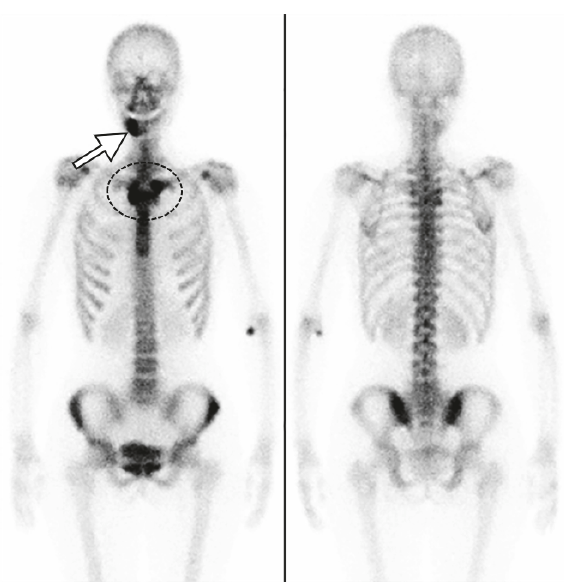
Figure 4: Bone scintigraphy. There is increased tracer uptake in the right mandible (arrow), sternum, and the sternocostoclavicular joints (dotted circle).